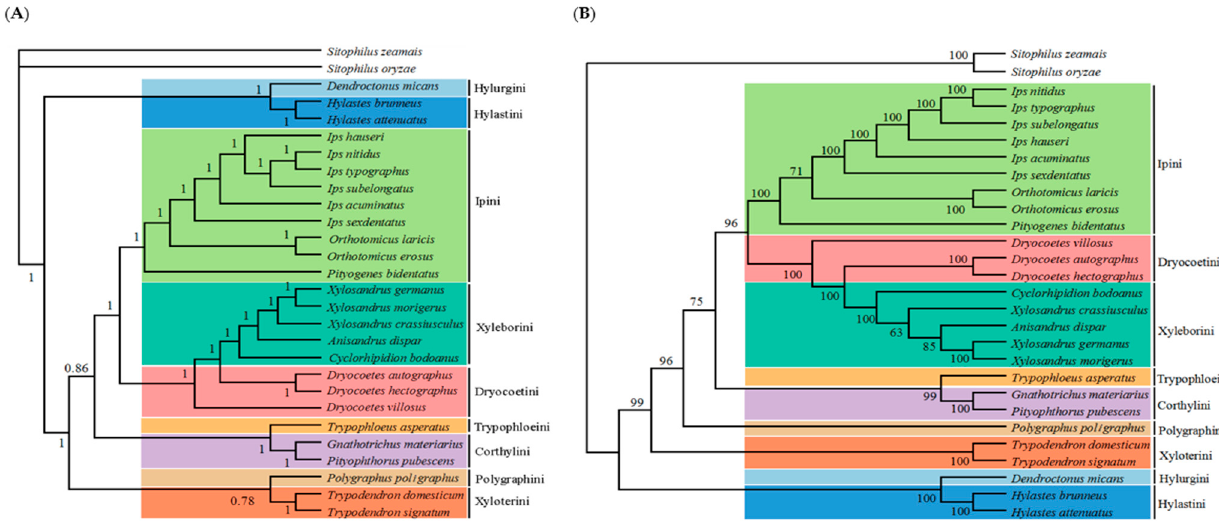
Figure 3. Phylogenetic tree inferred from mitogenomes of the subfamily Scolytinae using Bayesian inference method ( A ) and maximum likelihood method ( B ). Values at nodes indicate Bayesian posterior probabilities and bootstrap values for the BI and ML trees, respectively. Clades with different colors indicate different